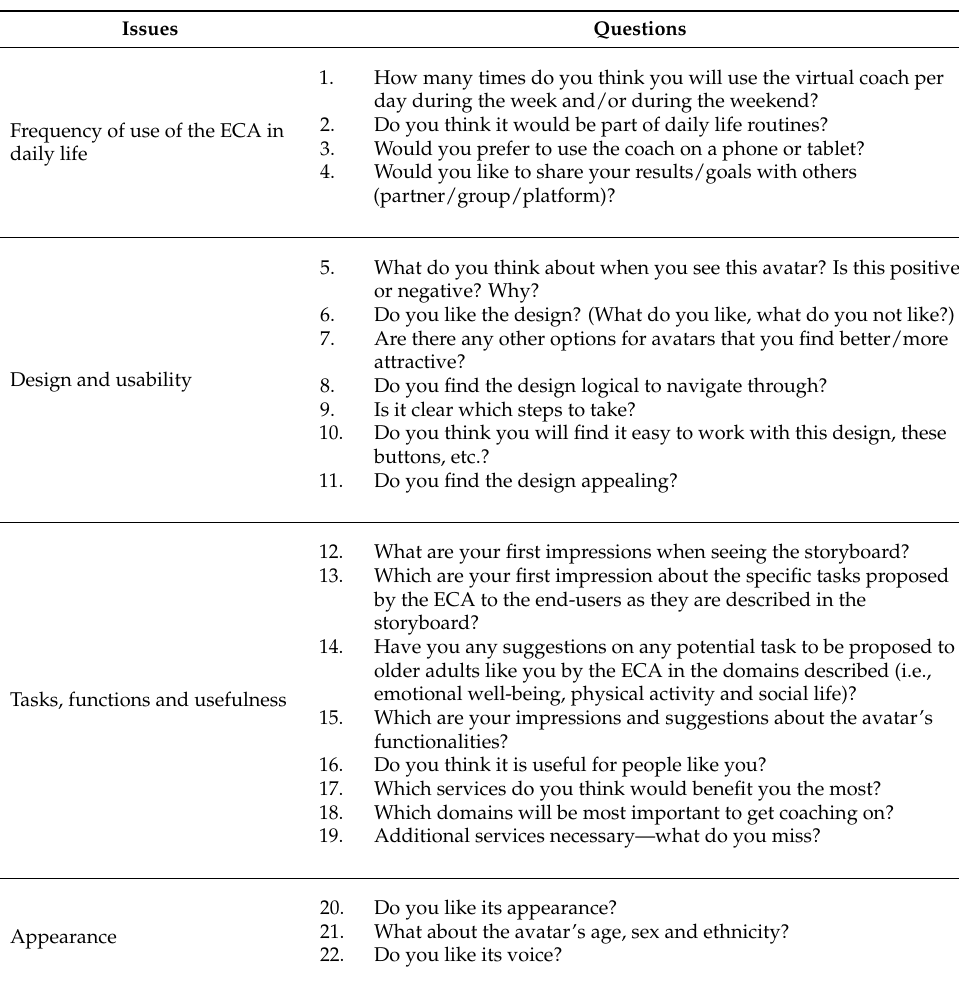
Table A2. Topic-guide of the Wave 2